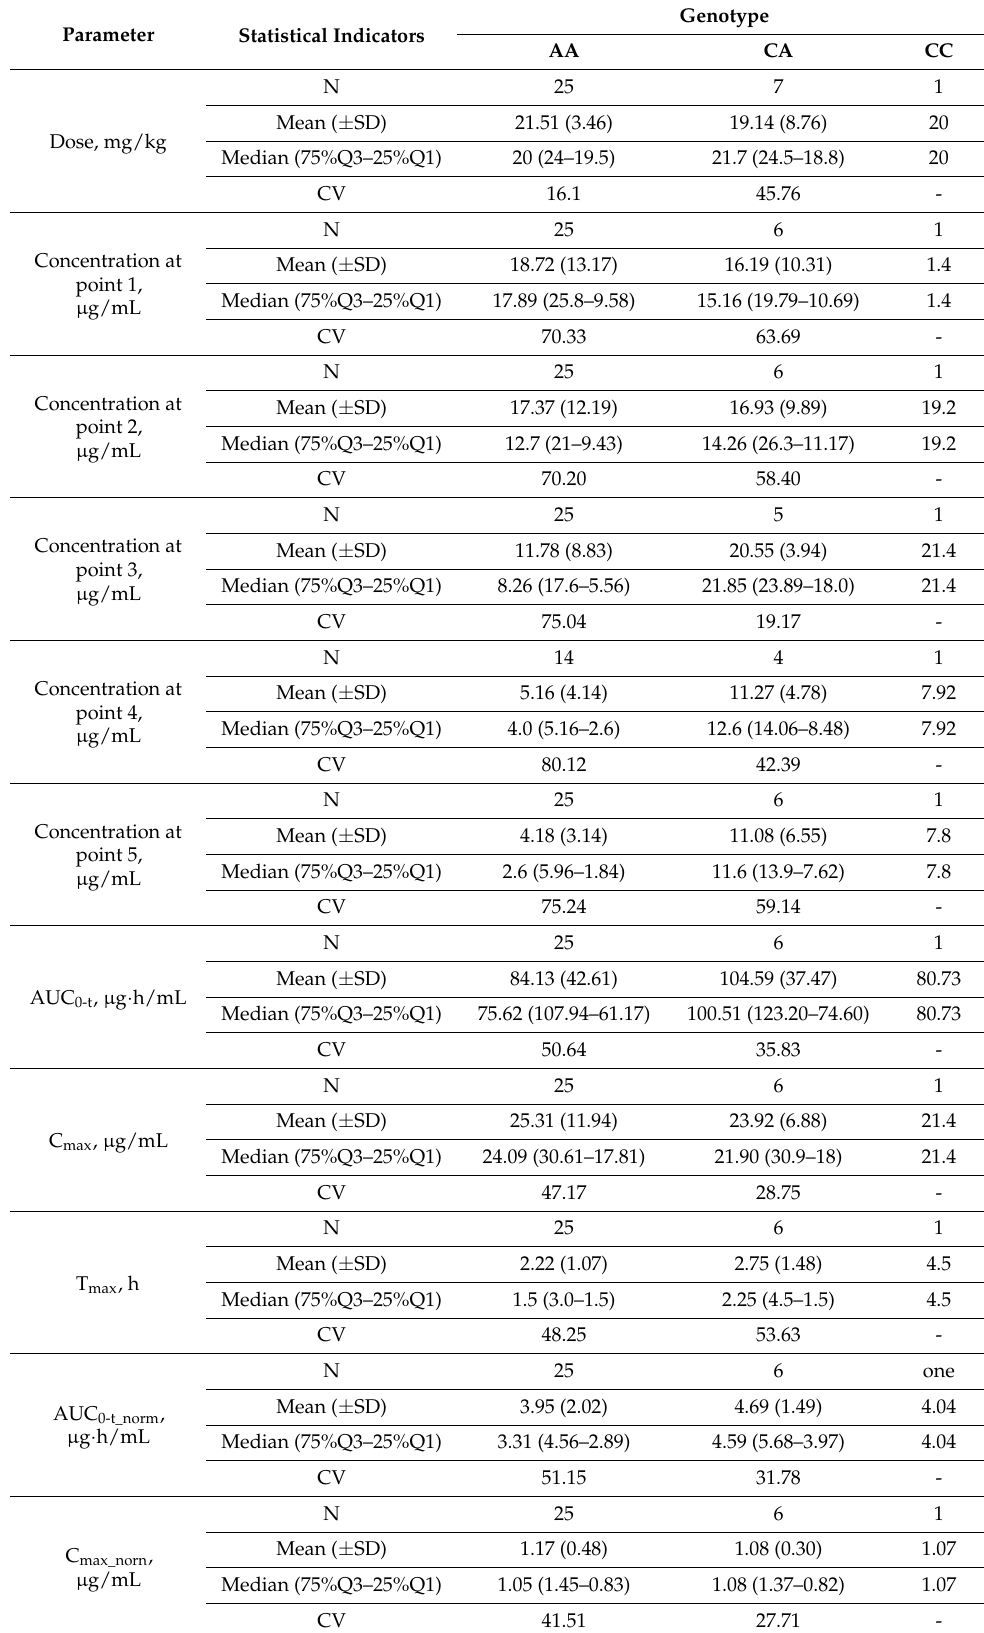
Table 4. Pharmacokinetic parameters of CPF depending on CYP2C9*3 gene polymorphism (I359L, c.1075A >